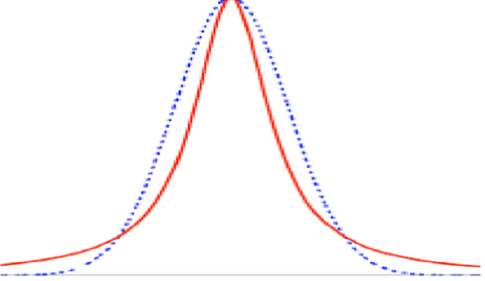
FIG. 4. Comparison of a normal distribution (dashed line) and a Cauchy distribution (solid line).